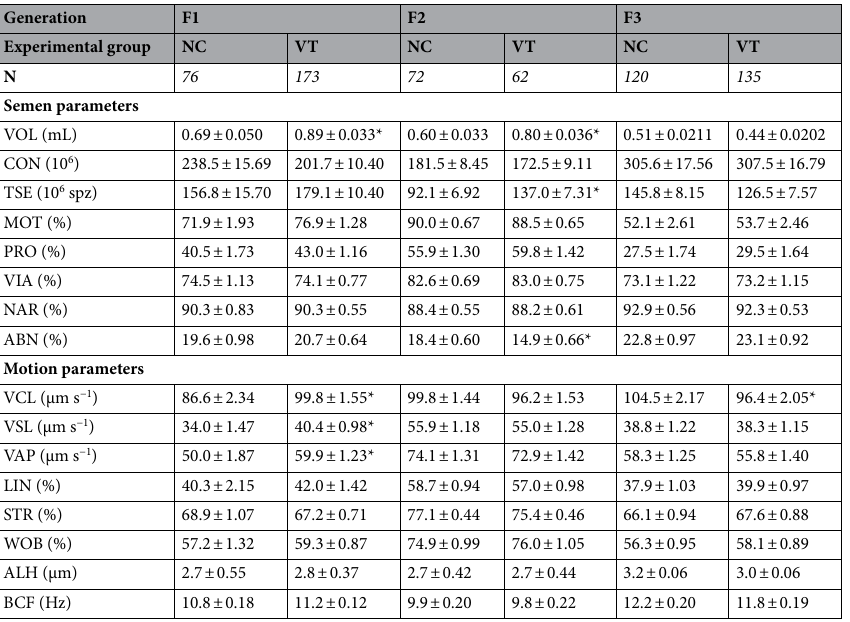
Table 2. Ejaculates/sperm parameters and motility assessment of males from the vitrified-transferred progeny (VT) compared to those naturally conceived (NC). Data are expressed as mean ± standard error of means. n number of ejaculates, VOL ejaculate volume, CON spermatic concentration, TSE total sperm per ejaculate, spz spermatozoa, MOT percentage of sperm motility, PRO percentage of progressive motility, VIA percentage of viable sperm, NAR percentage of normal apical ridge, ABN percentage of abnormal forms, VCL curvilinear velocity, VSL straight-line velocity, VAP average path velocity, LIN linearity coefficient (VSL/VCL × 100), STR straightness coefficient, WOB wobble coefficient (VSL/VAP × 100), ALH amplitude of lateral head displacement, BCF beat cross-frequency. *Asterisks denote relevant differences between VT traits and their NC counterparts (Bayesian inference: |D NC-VT |> R and P 0 > 0.8; Supplementary Table